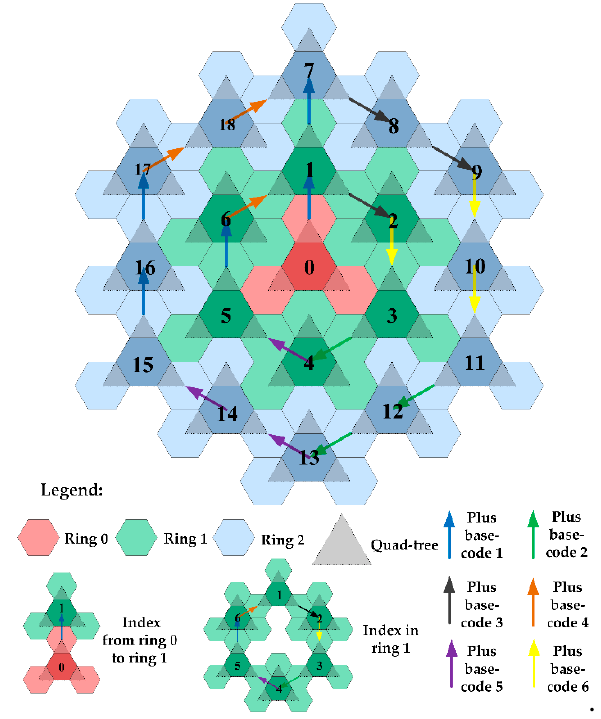
Figure 5. Schematic of the single-level code indexing algorithm.